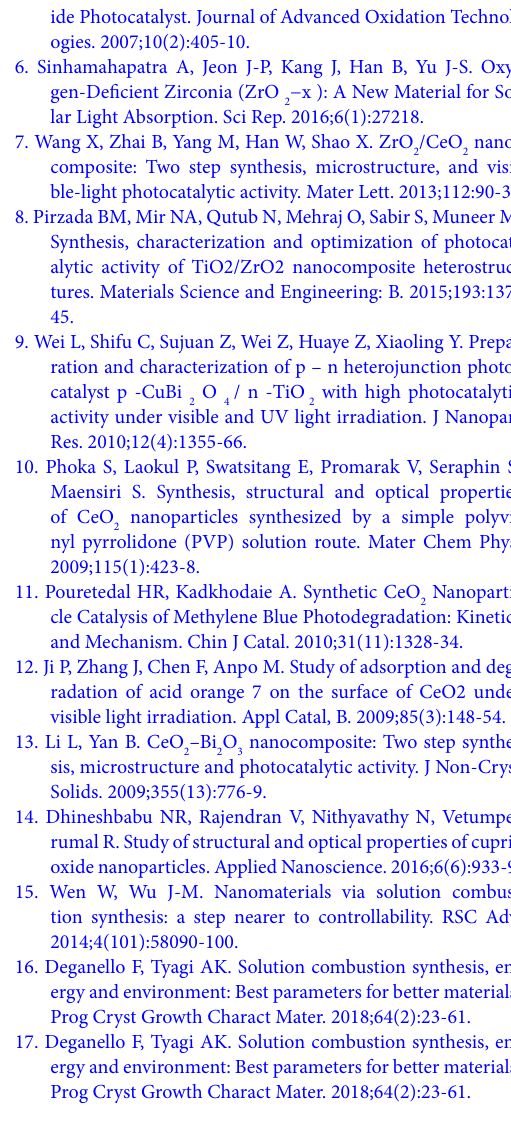
ide Photocatalyst. Journal of Advanced Oxidation Technol- ogies. 2007;10(2):405-10. 6. Sinhamahapatra A, Jeon J-P, Kang J, Han B, Yu J-S.